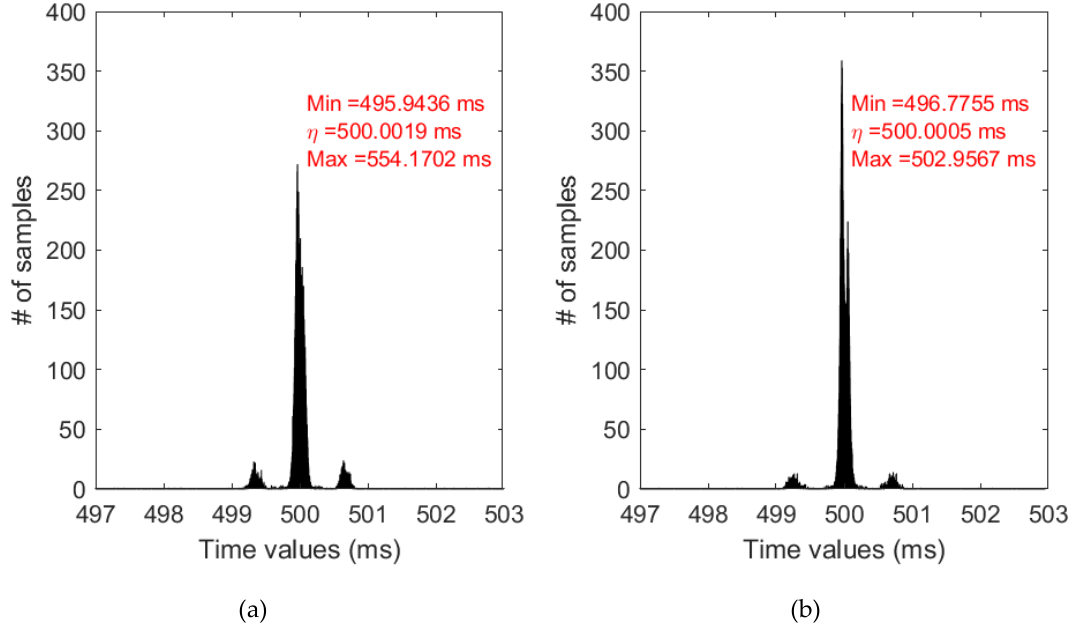
Figure 9. Control sampling time rate distributions during ( a ) discharging and ( b ) charging phases.